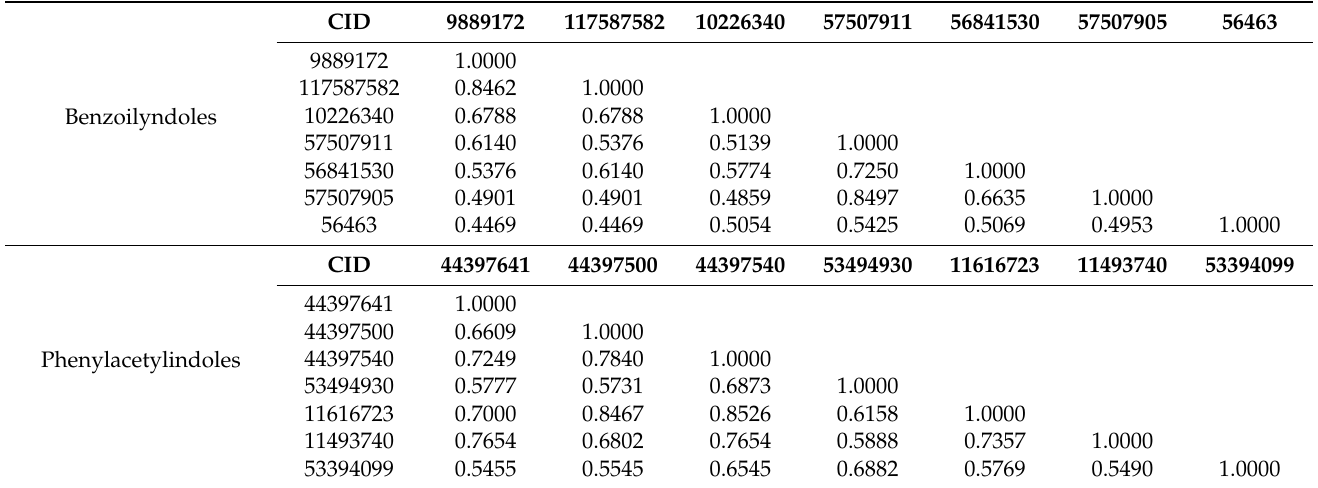
Table 4. Tanimoto coefficients for the atoms’